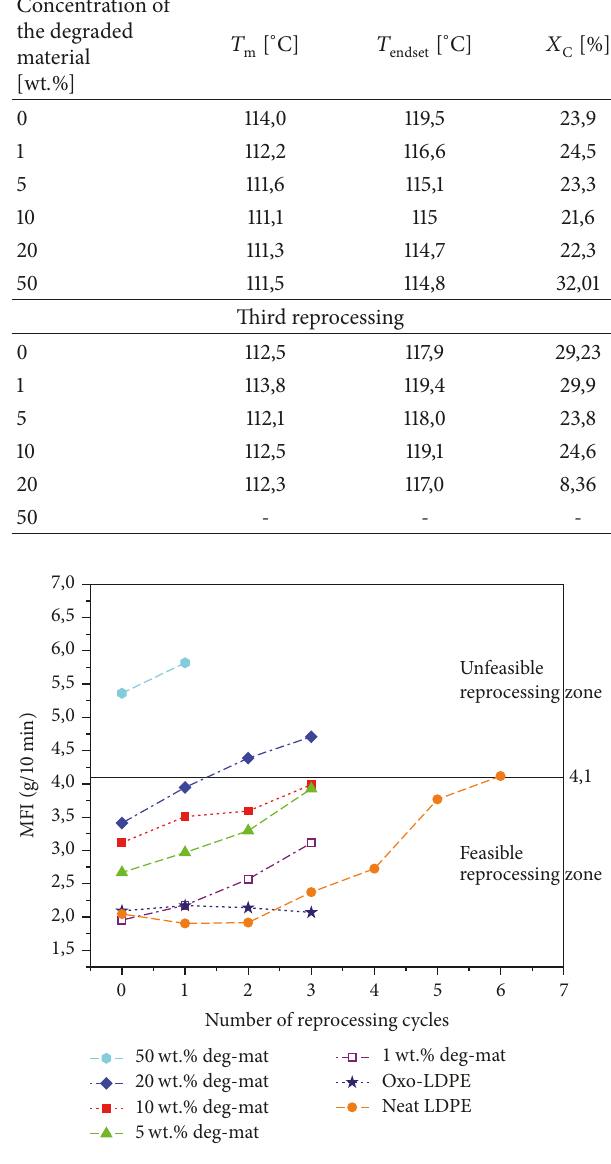
Table 3: DSC analyses data of the neat LDPE and degraded mate- rial/LDPE blends. The third reprocessing data is also considered. Concentration of